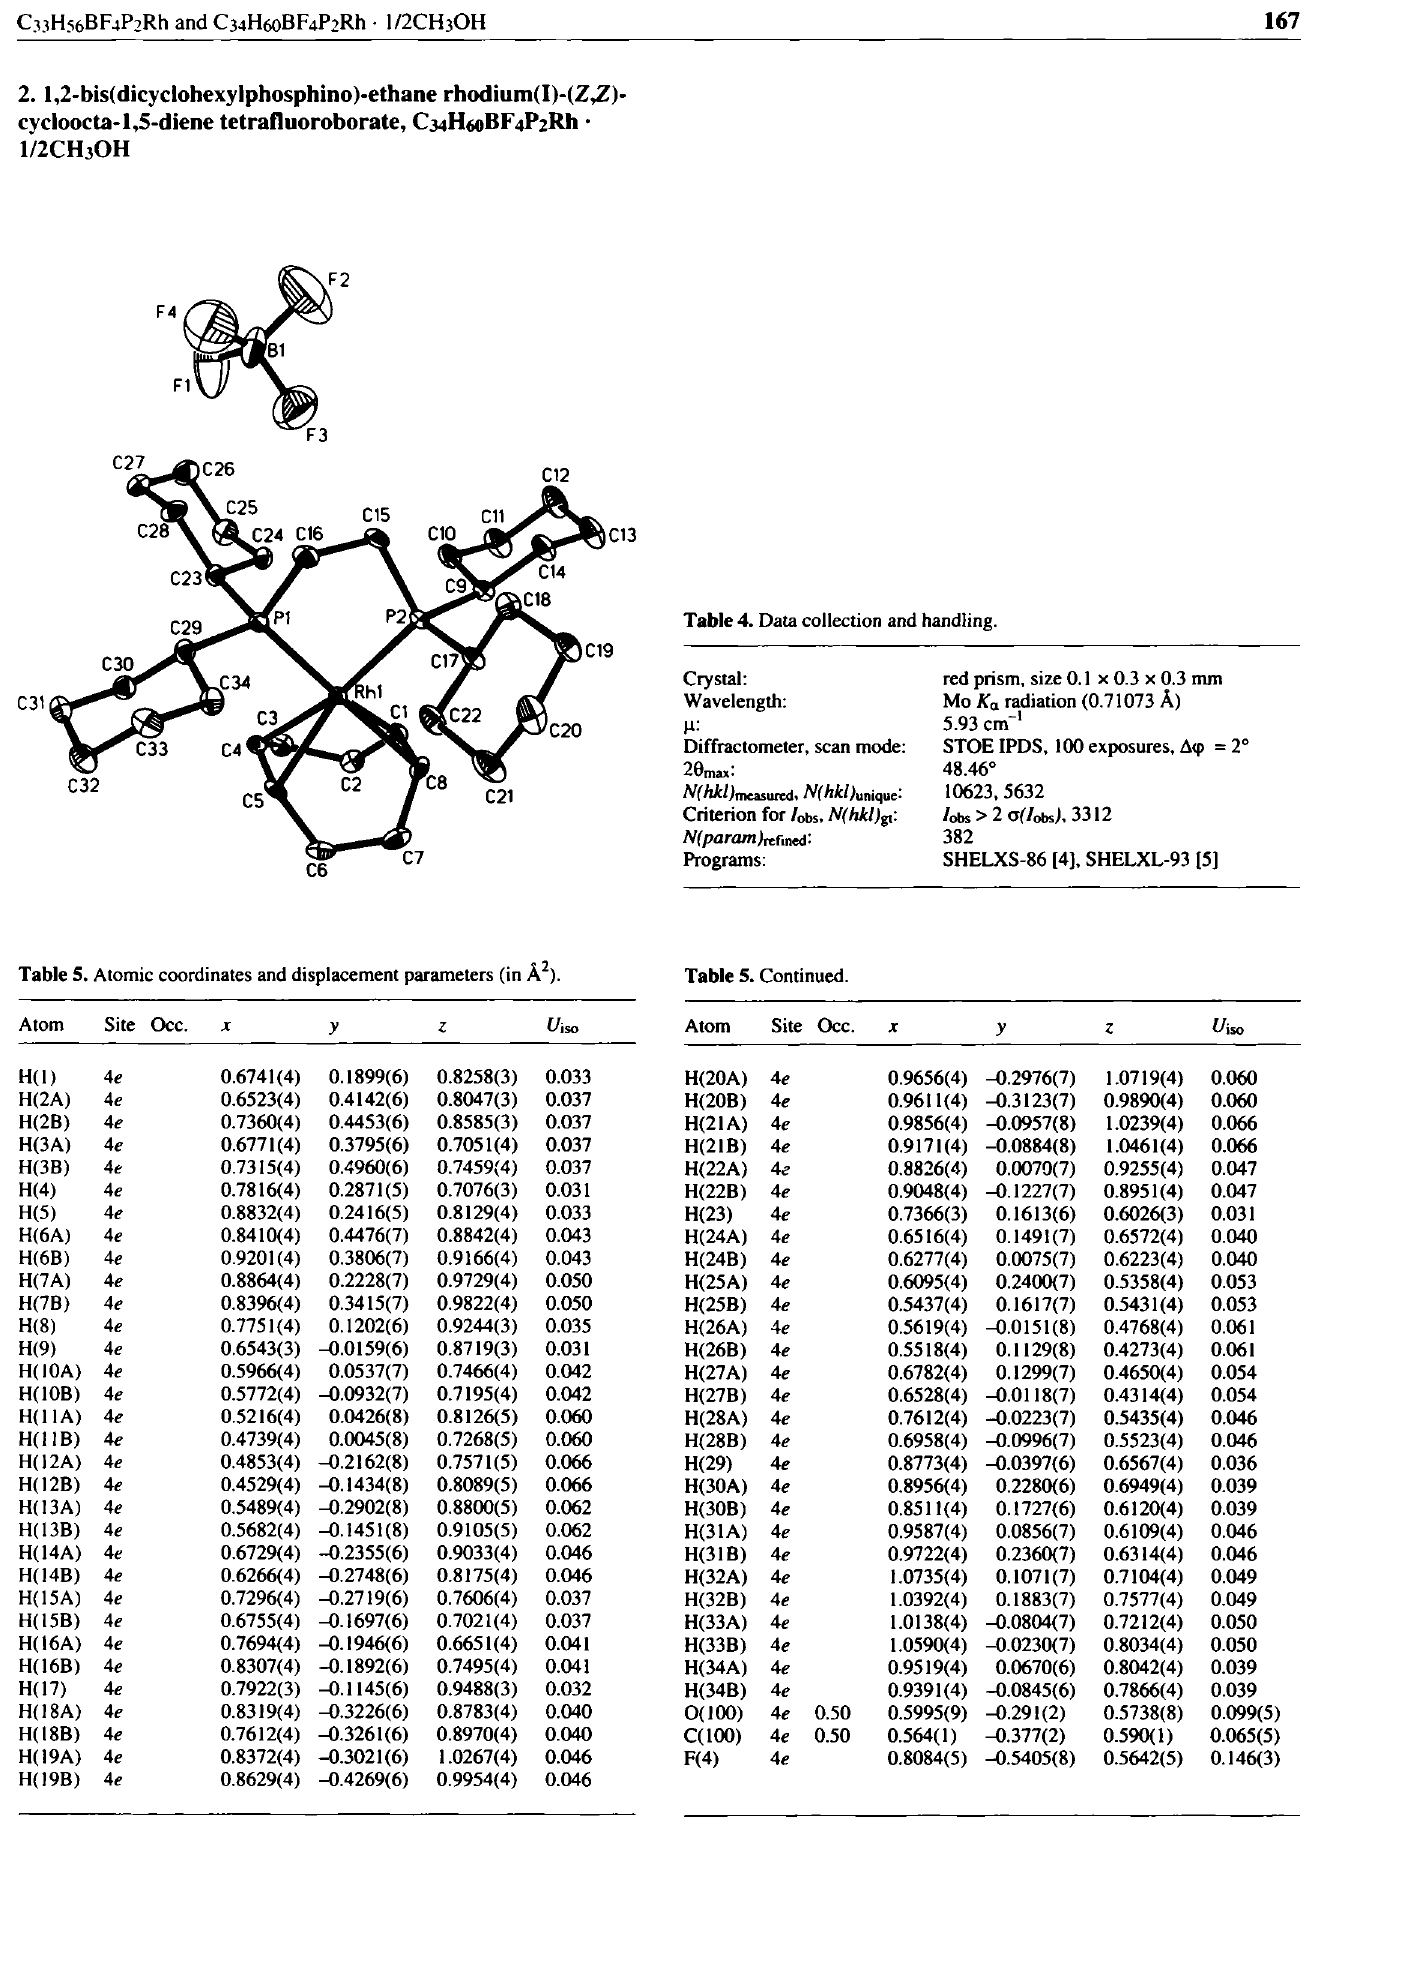
Table 4. Data collection and handling.